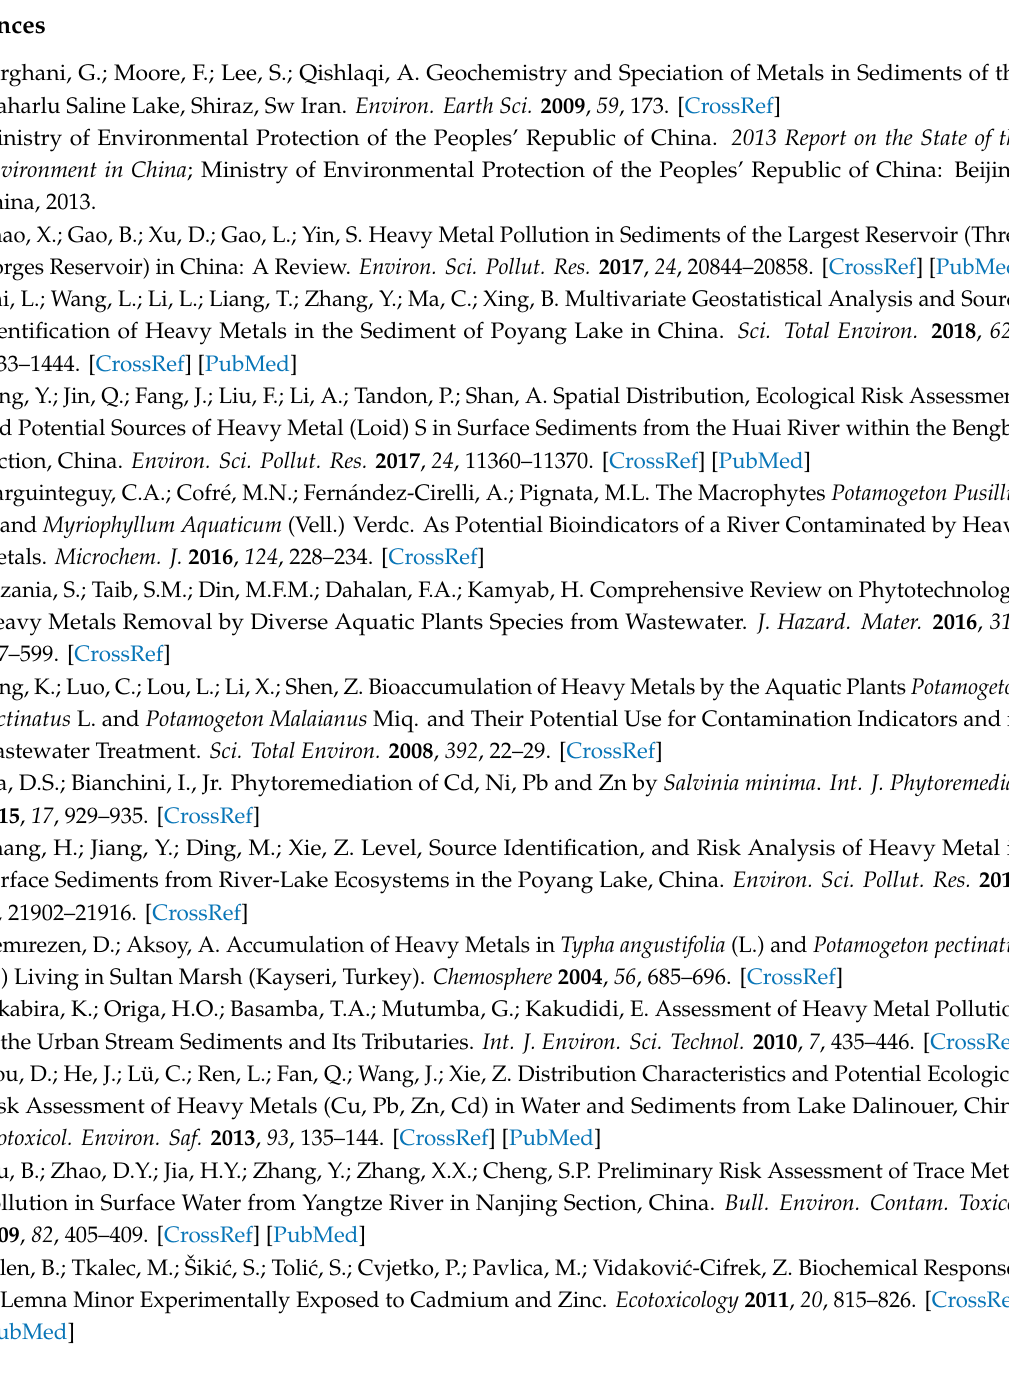
Table S1: Longitude and latitude of the water sampling sites; Table S2: Longitude and latitude of the sediment sampling sites; Table S3: Bioconcentration factors of Potamogeton crispus in April, 2017; Table S4: Bioconcentration factors ( × 10 3 ) of Salvinia natans in September, 2017; Table S5: Heavy metal levels in sediment of eight sites in April, 2017 (mg /